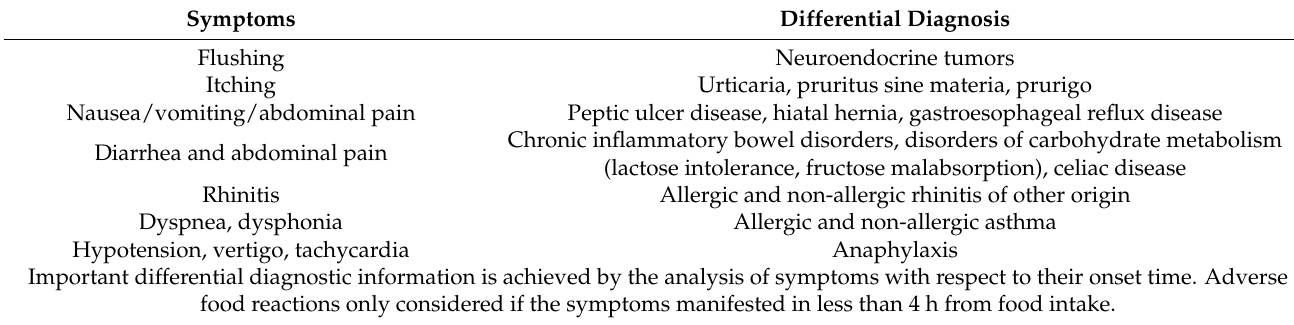
Table 1. Symptoms and differential diagnostics in patients with suspected adverse reactions to ingested histamine. Adapted according to Reese et al. 2017